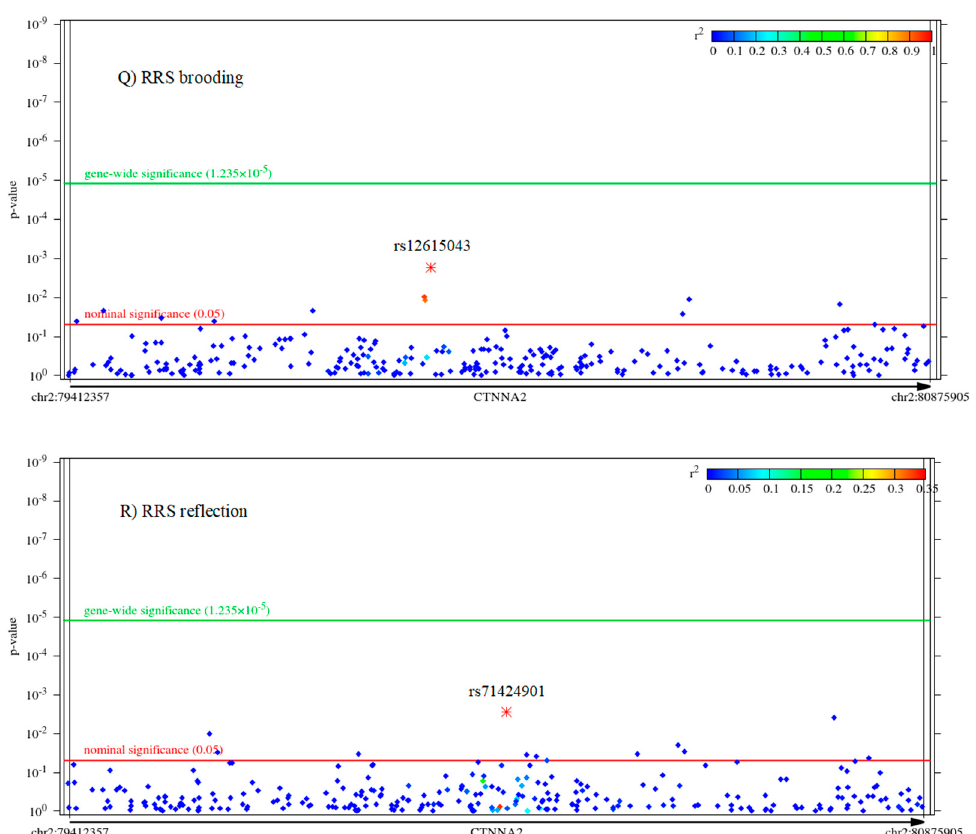
Figure 1. Manhattan plots for the associations of each CTNNA2 SNP with each outcome variable. ( A – E ) display cardiovascular risk phenotypes, ( F – O ) display BSI psychiatric symptom scores, and ( P – R ) display RRS rumination, brooding and reflection scores, respectively. The p -value is displayed with two thresholds, Bonferroni-corrected gene-wide and nominal significance, as a function of the SNP position within the gene. We can see that, while no SNP survived the gene-wide significant threshold, there are nominally significant associations for all 18 phenotypes. R 2 —linkage disequilibrium with the most significant SNP (marked with asterisk and given by name); SNP—single-nucleotide polymorphism;